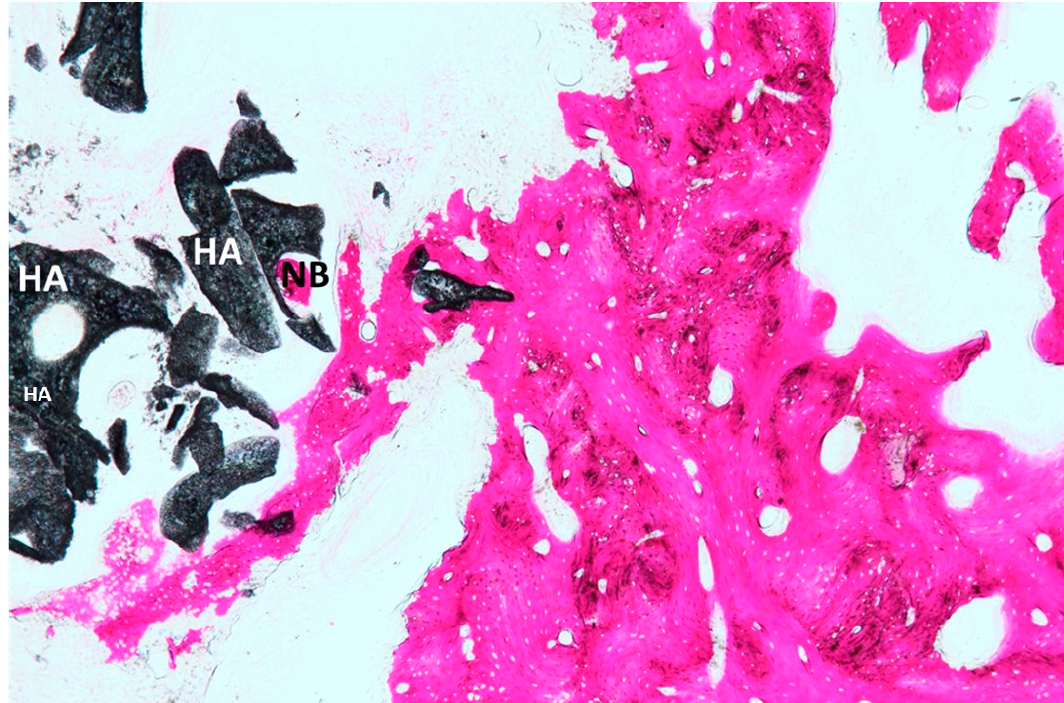
Figure 6. At a higher magnification, we observed a new bone (NB) in direct contact with the HA scaffold (HA). Acid fuchsin and toluidine blue staining 50× (× indicates the magnification power of the microscopical observation).